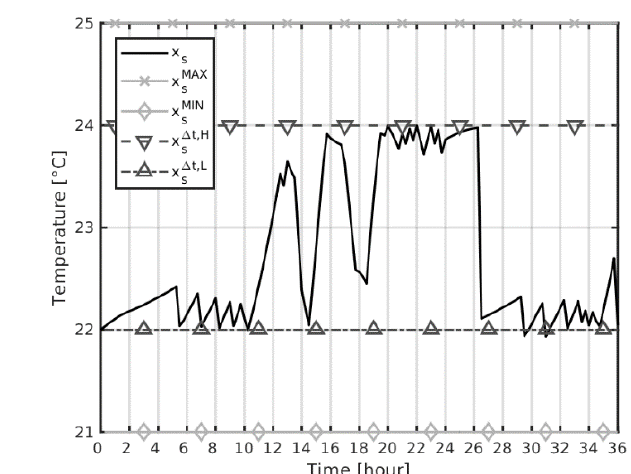
Figure 7. Air-conditioned room temperature vs. time, as per the optimised solution to the reference problem.